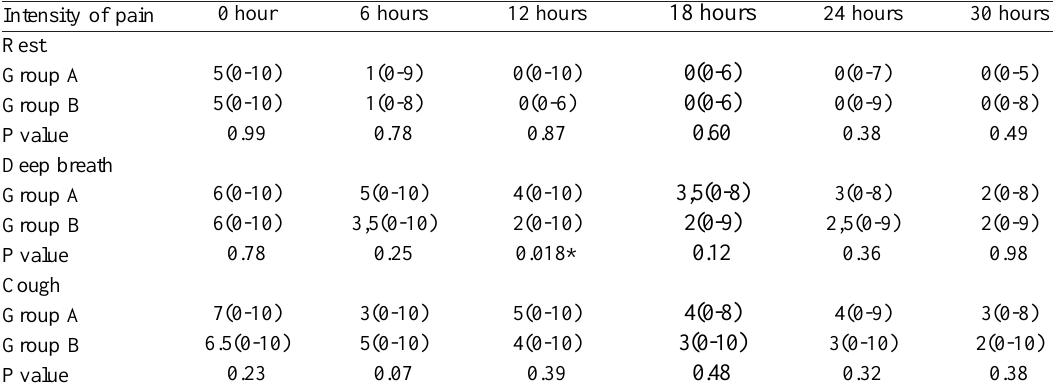
Table 3. Intensity of pain, at rest, deep breath and cough in PCA alone (Group A) and PCA plus continuous infusion (Group B).